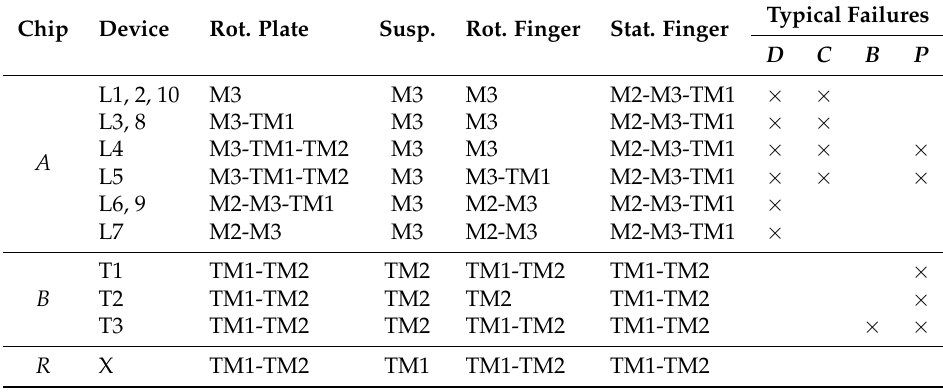
Table 2. Layer composition of lateral devices on Accused , Bailed and Released chips. The typical failures are: device Delamination, Curling, Buckling and Peeling of Ti/TiN or